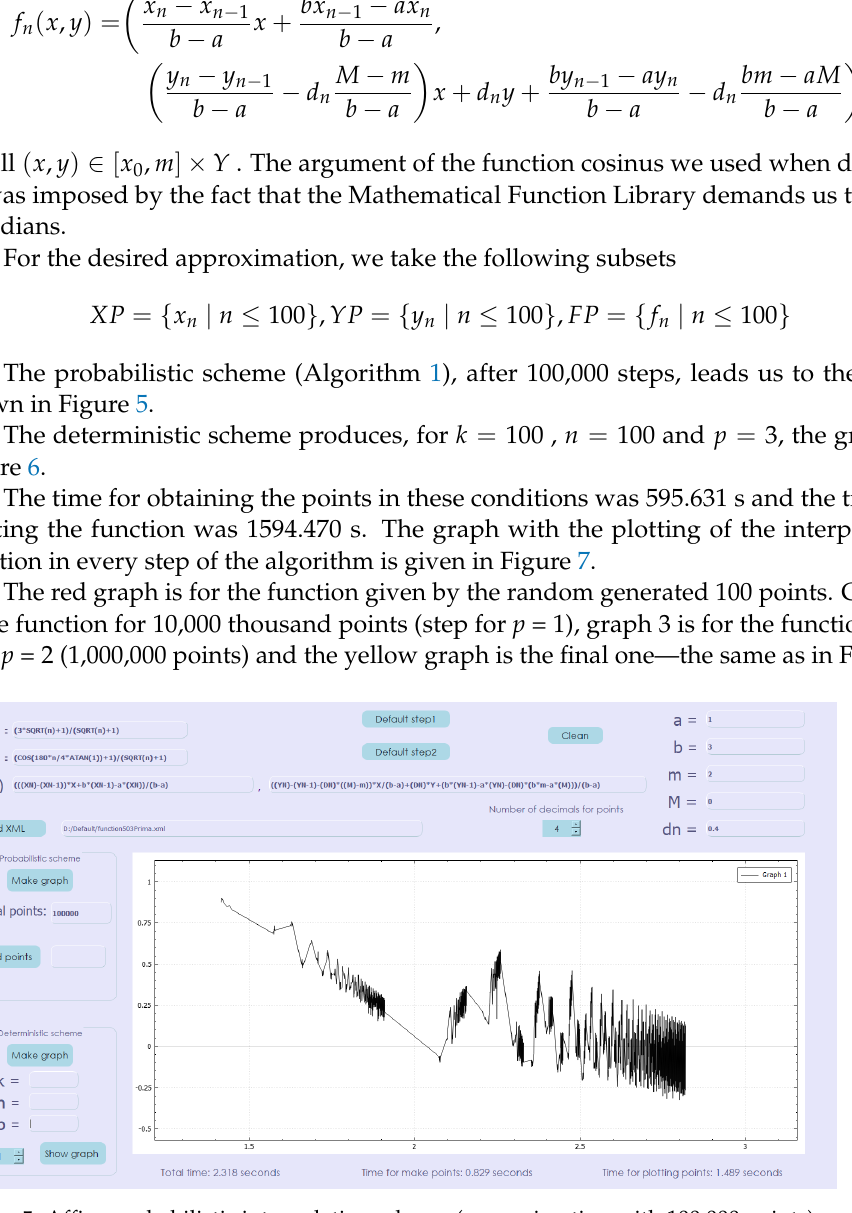
Figure 5. Affine probabilistic interpolation scheme (approximation with 100,000